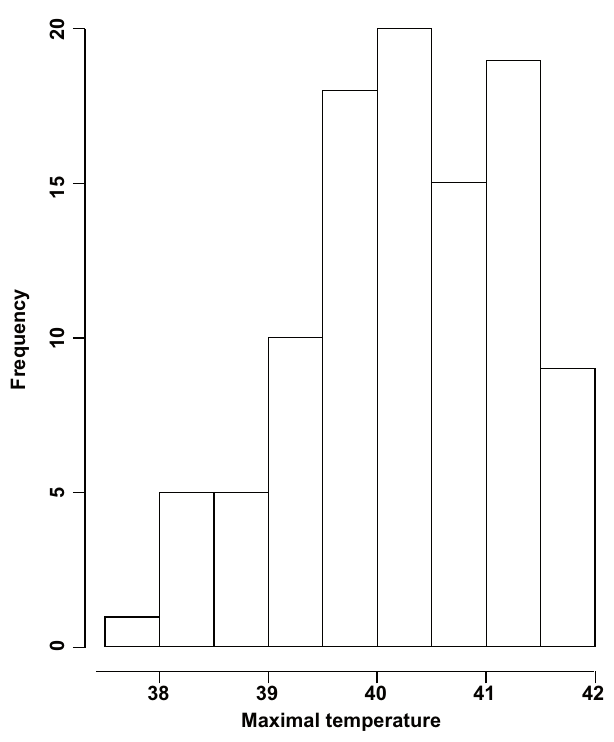
Figure 3. Distribution of maximal temperature (Tmax) ( ° C). Histogram of frequencies of maximal temperature of the included patients.